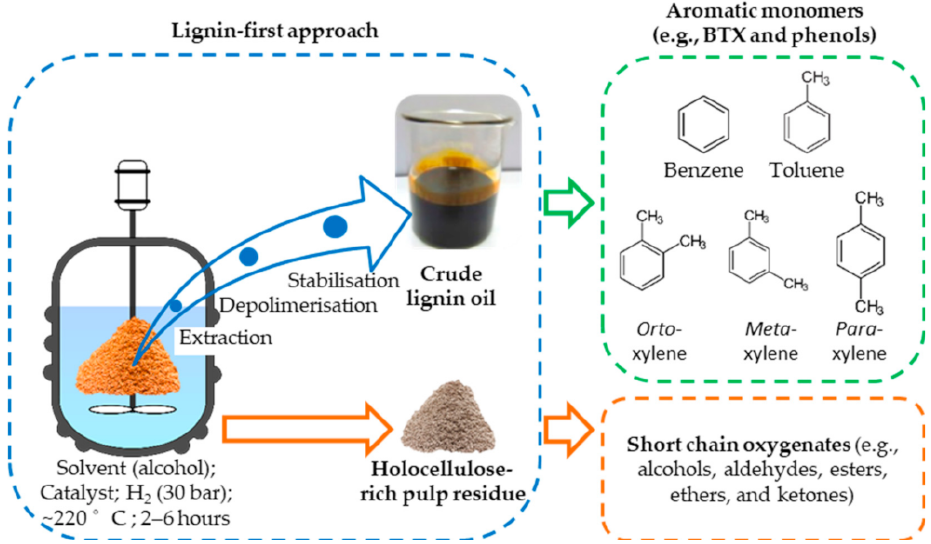
Figure 3. Schematic overview of the lignin-first approach and potential value-added